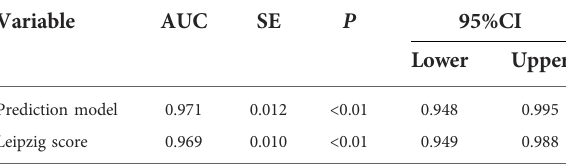
TABLE 4 AUC comparison of prediction models and Leipzig score for Wilson ’ s disease Variable AUC